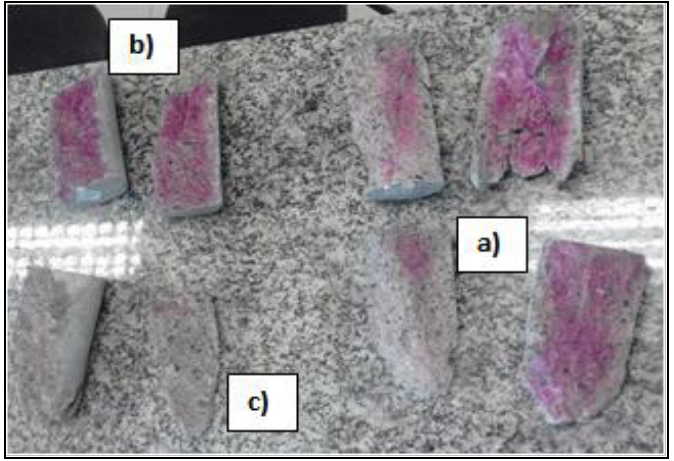
Figura 9: Corpos de prova após a aplicação do indicador químico de fenolftaleína. a) Traço com 0,0% de fibra; b) Traço com 0,5% de fibra; c) Traço com 1,0% de fibra.